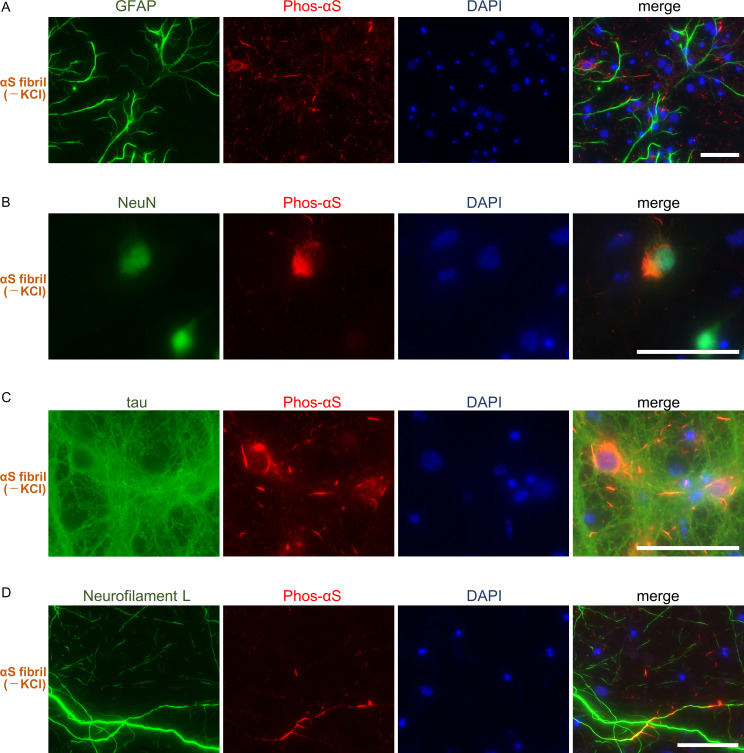
Double stained Images of phosphorylated α-synuclein and neuronal or astrocyte markers.α-synuclein fibrils (-), which induced the accumulation of phosphorylated α-synuclein, were transduced into primary mouse cortical cells. 14 days after fibril transduction, phosphorylated α-synuclein and neuronal or astrocyte markers were doubly stained. (A) Phosphorylated α-synuclein (Phos-αS), GFAP (an astrocyte marker) and nuclei (DAPI) were stained. (B) Phosphorylated α-synuclein (Phos-αS), NeuN (a mature neuronal cell marker) and nuclei (DAPI) were stained. (C) Phosphorylated α-synuclein (Phos-αS), tau (a mature neuronal cell marker) and nuclei (DAPI) were stained. (D) Phosphorylated α-synuclein (Phos-αS), Neurofilament-L (a mature neuronal cell marker) and nuclei (DAPI) were stained. Scale bars, 50 µm.